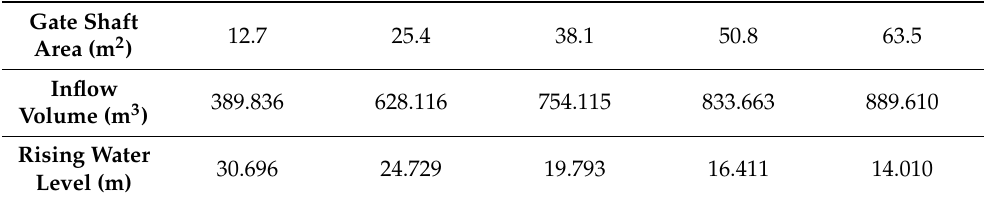
Table 6. The inflow and rising water level when the water level under different gate shaft areas has reached its highest point.